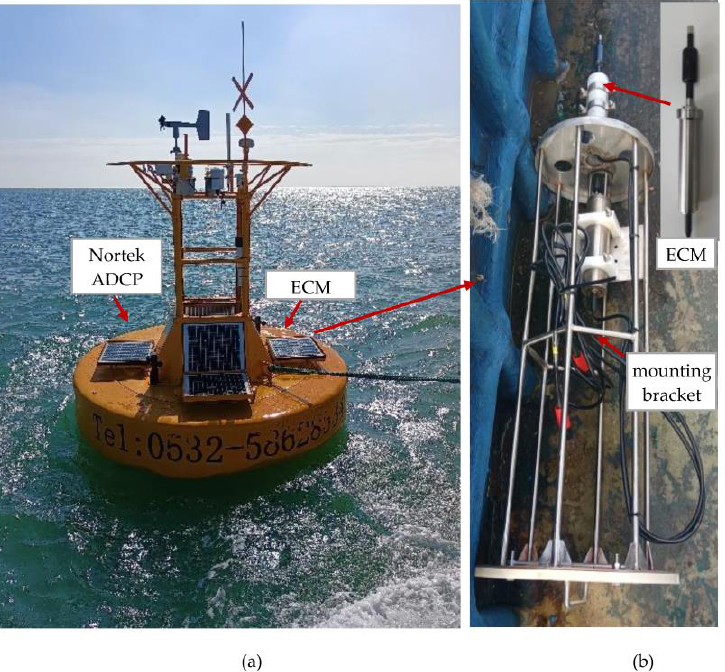
Figure 13. The test 3 m buoy and the ECM. ( a ) The test 3 m buoy. ( b ) the ECM and underwater mounting bracket.